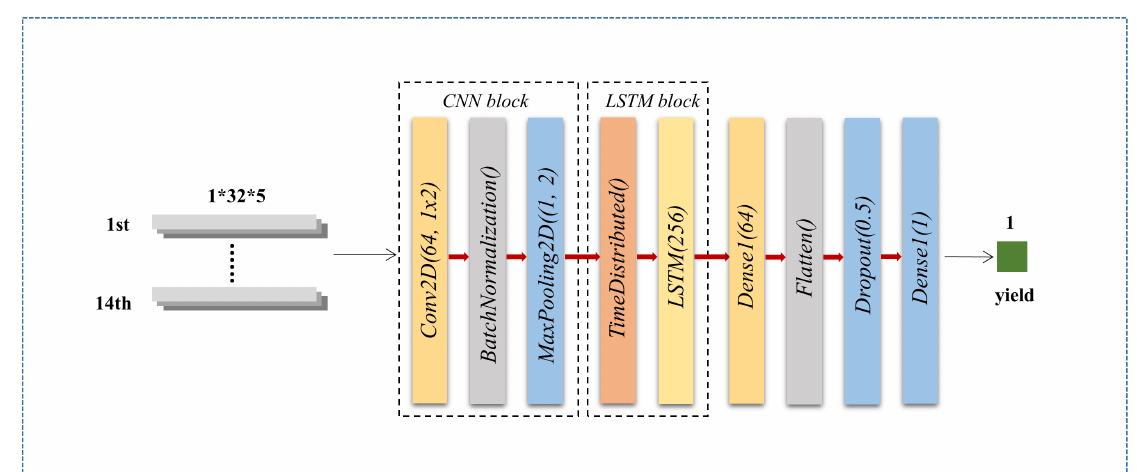
Figure 3. The architecture of the CNN-LSTM